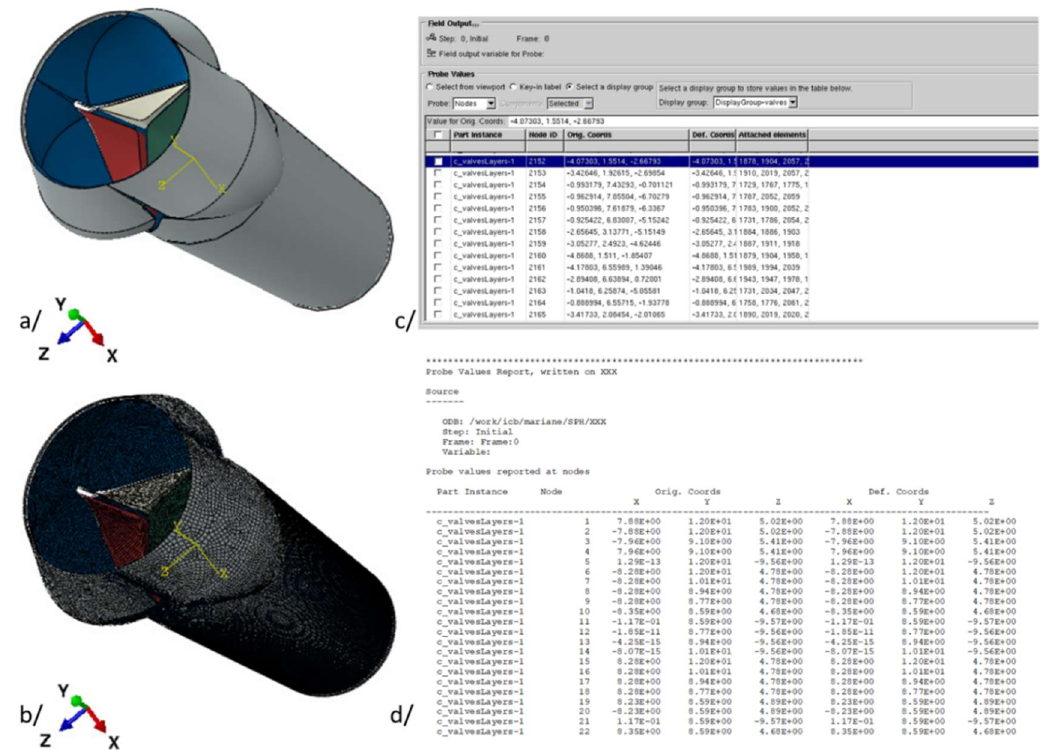
Figure A2. Tricuspid valve CAD part ( a ), tricuspid valve meshed CAD part ( b ), nodes generation using the CAD software ( c ), and external data file ( d ).